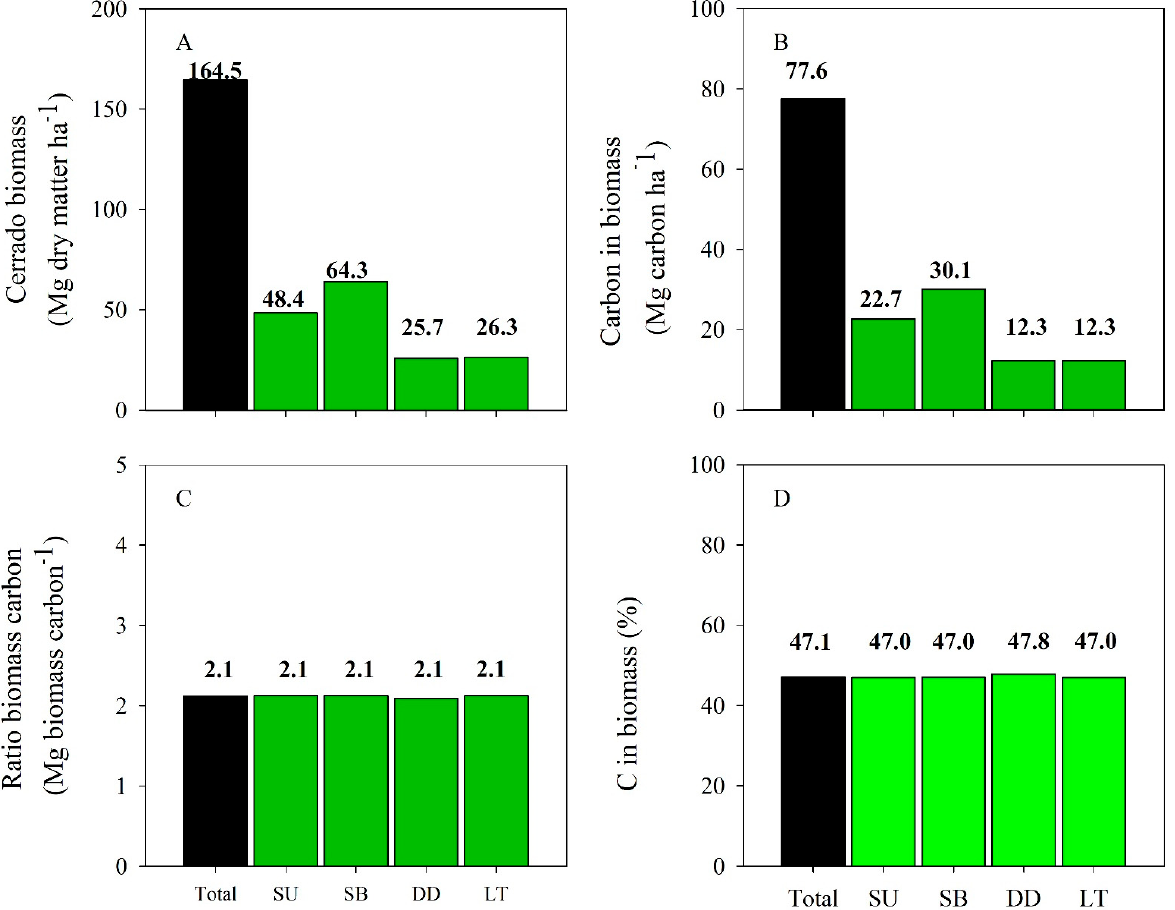
Figure 2. Biomass (Mg dry matter ha − 1 ), carbon in biomass (Mg carbon ha − 1 ), ratio biomass carbon (Mg biomass carbon − 1 ), and carbon in biomass (%) in Cerrado vegetation in surface (SU), subsurface (SB), deadwood (DD), litter (LT), and total (sum of all).